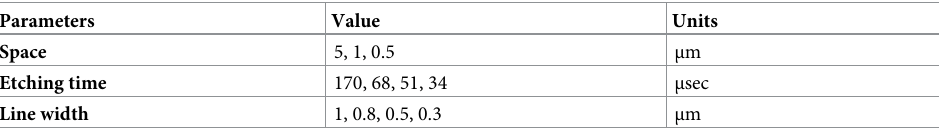
Table 1. The input features for the aspect-ratio dependent etching (ARDE) experiments for the 2-input dataset [46].